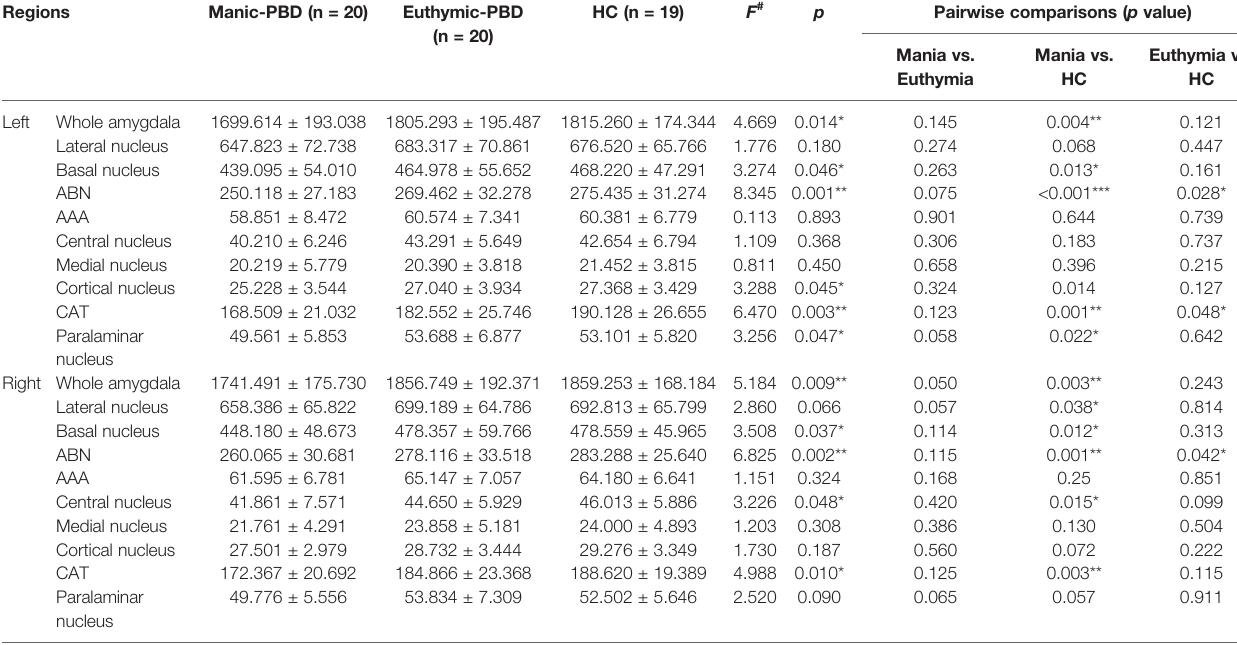
TABLE 2 | The difference among the three groups in the amygdala and subnuclei.